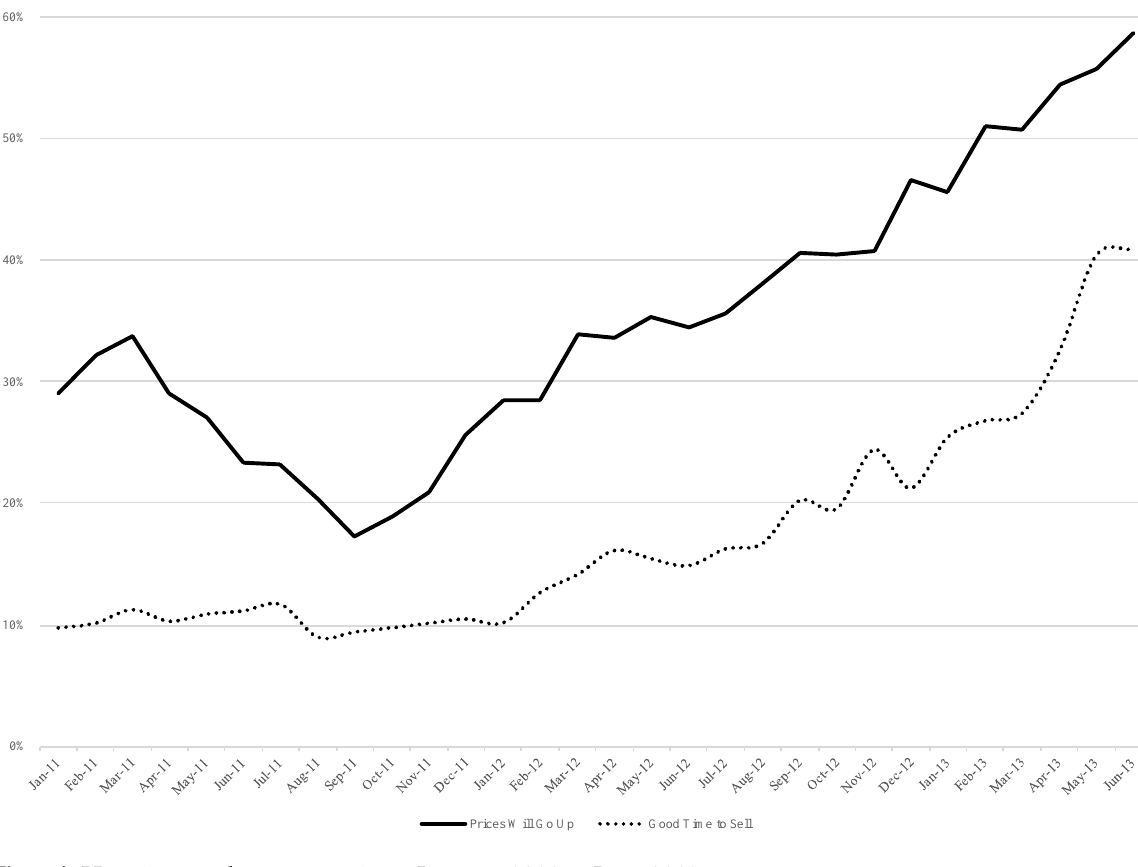
Figure 1: Housing market expectations, January 2011 to June